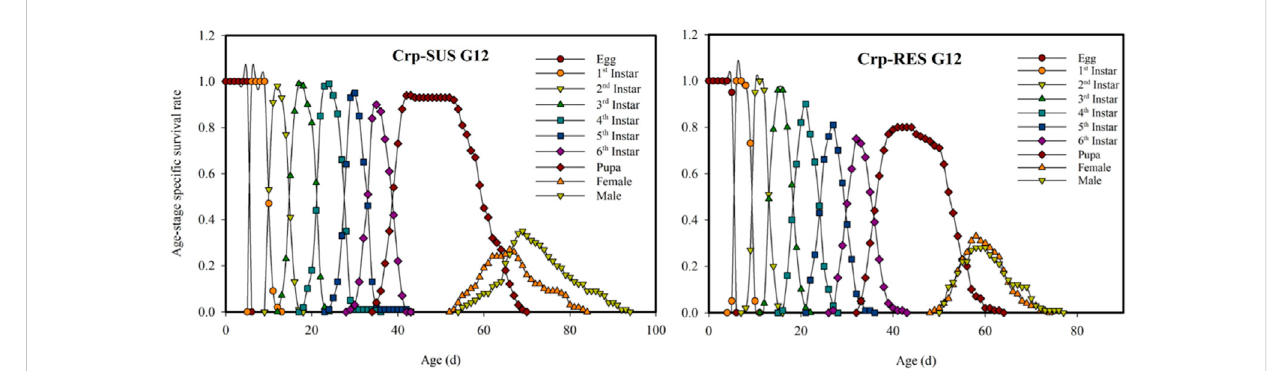
FIGURE 1 Age-stage-speci fi c survival rate ( s xj ) for the Crp-RES G 12 and Crp-SUS G 12 strains of Spodoptera frugiperda .